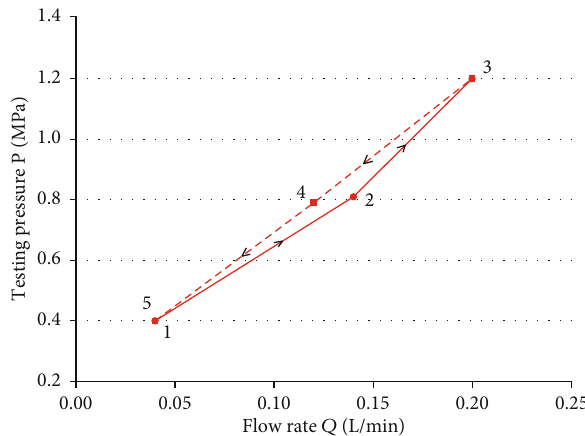
Figure 2: Diagram of stable fl ow rate and testing pressure variation at the fi ve test